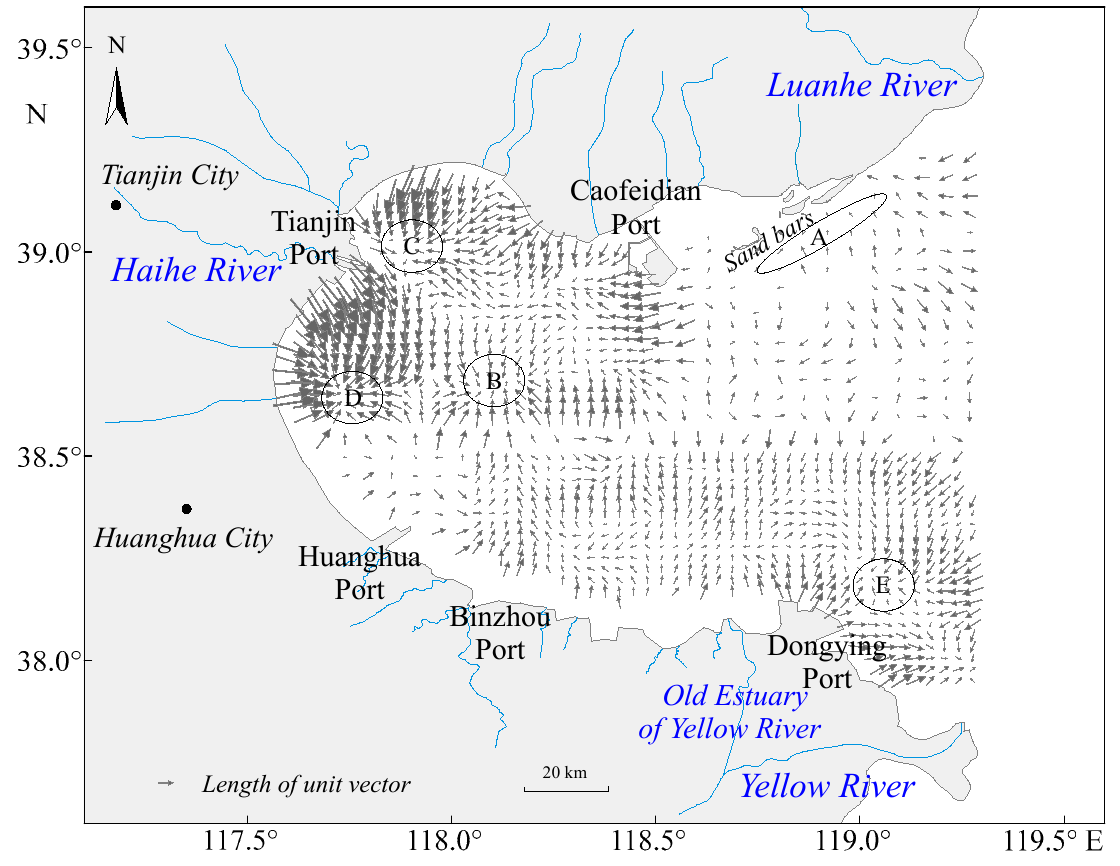
Figure 2. Distribution of the grain size trend vectors in Bohai Bay. Letters A, B, C, D and E indicate sediment accumulation areas.